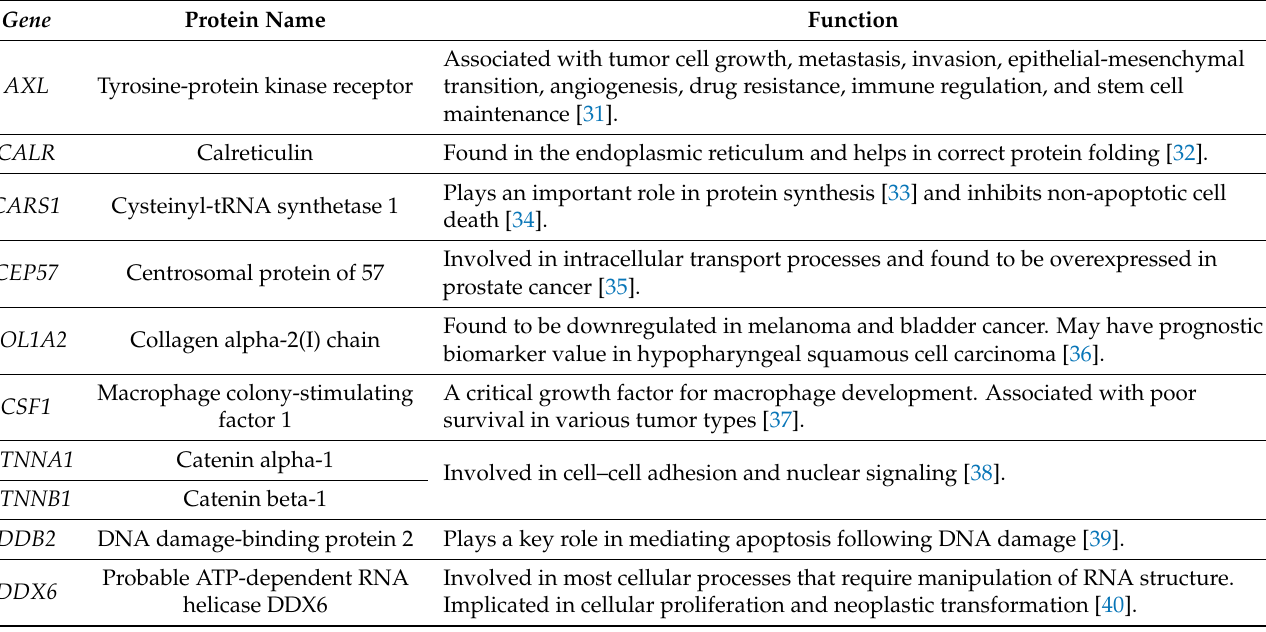
Table 6. Details of proteins that are present in all the EV pellets from all five mesothelioma cell lines and absent in all of the EV pellets from the control cell line